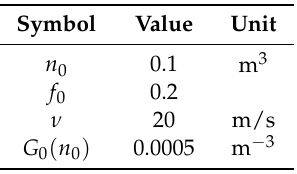
Table 1. The simulation parameters of the random